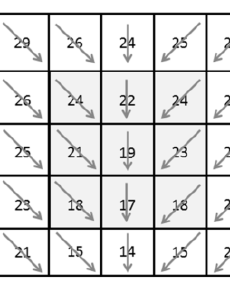
Figure 10. Flow directions evaluated with D8 algorithm.